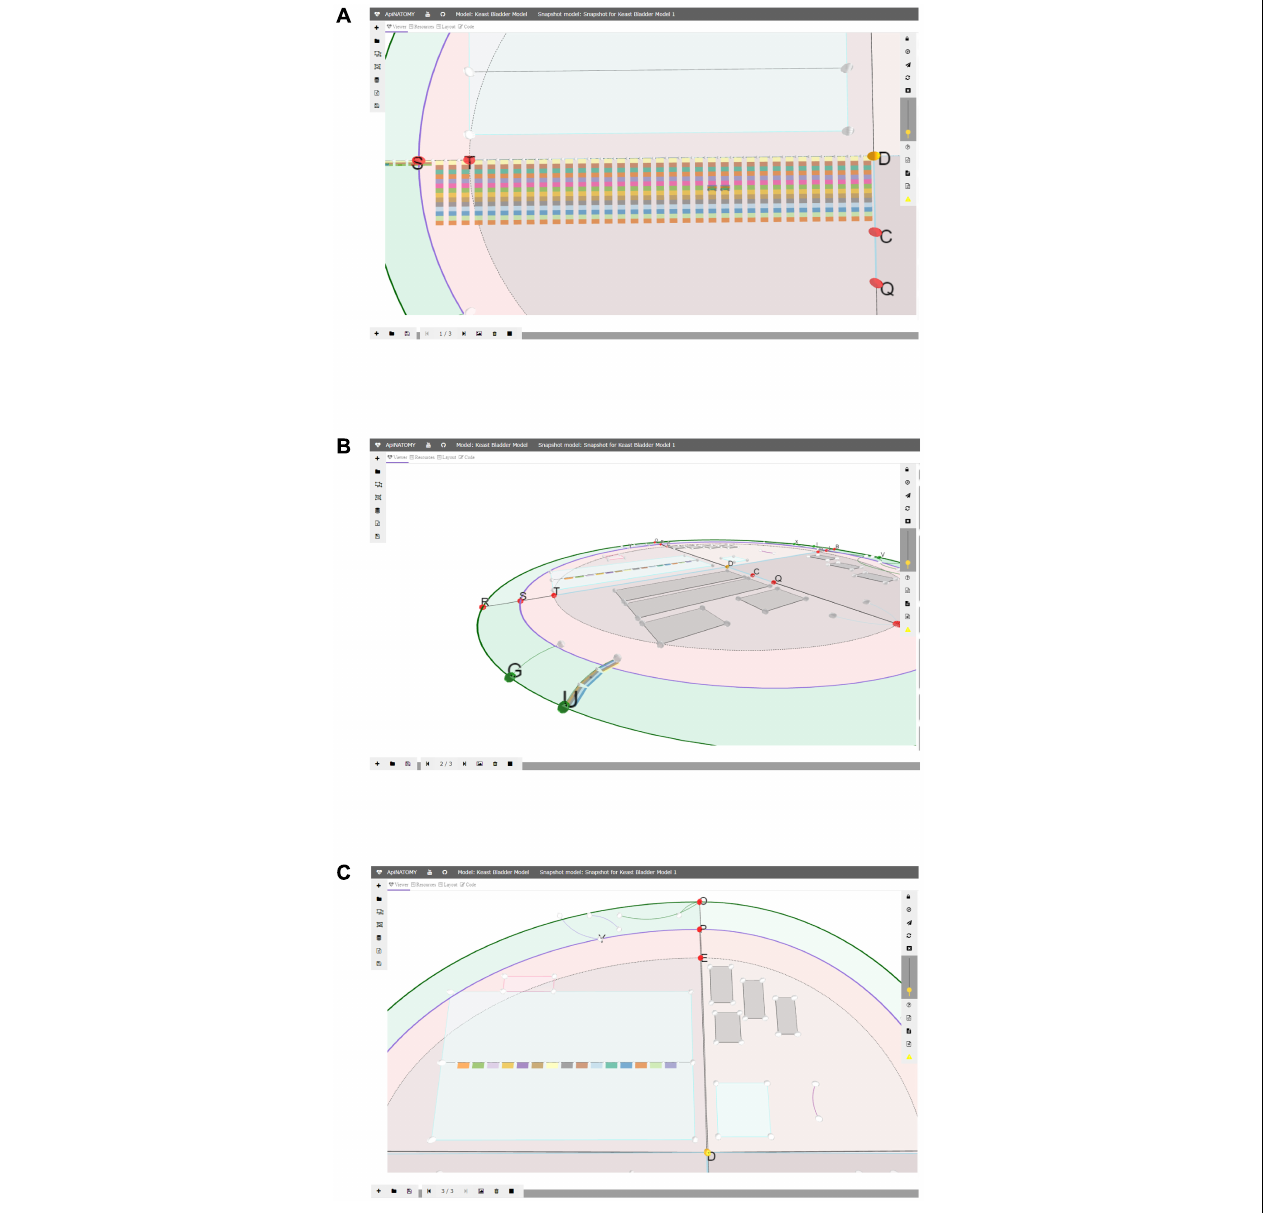
FIGURE 4 | A snapshot model with three states: in panel (A) we emphasized the layered ApiNATOMY representation of the Spinal Cord; in panel (B) we show a Urinary Tract chain (U) from a different camera angle; in panel (C) we resized segments of the TOO Map and reshaped some scaffold regions, most notably, Infracervical Ganglia region featuring basic elements of the Sympathetic